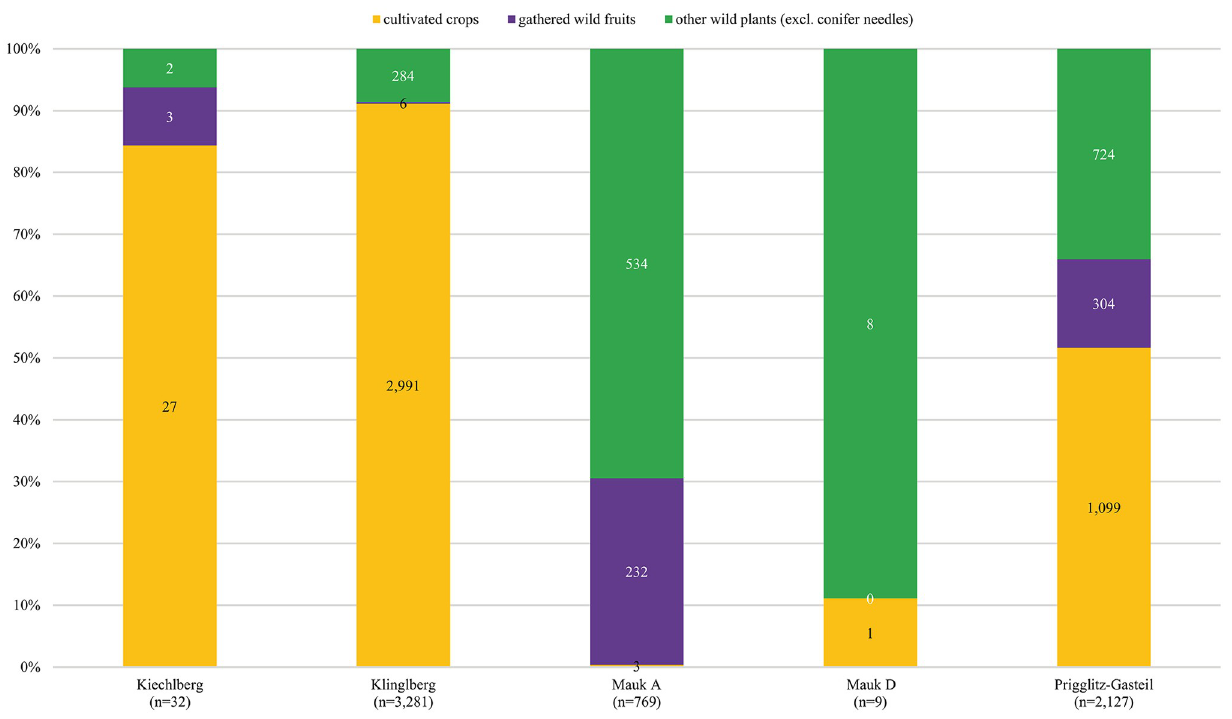
Fig 18. Overall composition of the identifiable archaeobotanical remains (absolute counts) from the copper production sites discussed in this paper [6, 12, 16, 17, 26, 27]. Conifer needles are excluded as “background noise”. Illustration: OeAW-OeAI/A. G. Heiss.